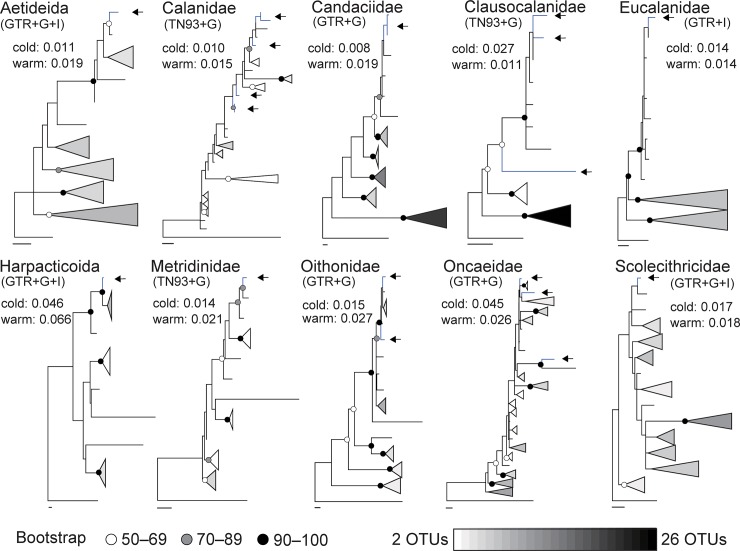
Phylogenetic analysis of taxonomic groups of operational taxonomic units (OTUs) with warm-water and cold-water distributions.OTUs with cold-water distribution are indicated by arrows. Bootstrap values at the nodes are inferred from maximum likelihood analysis (white, grey, black). Genetic lineages containing multiple OTUs with warm-water distribution are presented as triangles for simplicity, and the number of OTUs within each triangle is represented by the white–black spectrum. The length of each triangle corresponds to the length of the deepest node of each lineage. Scale bars indicate 0.02 genetic distances. The average nearest genetic distance is indicated for OTUs with warm-water and cold-water distributions in each taxon. The nucleotide substitution models used are indicated for each taxon (GTR: General Time Reversible; TN93: Tamura-Nei).